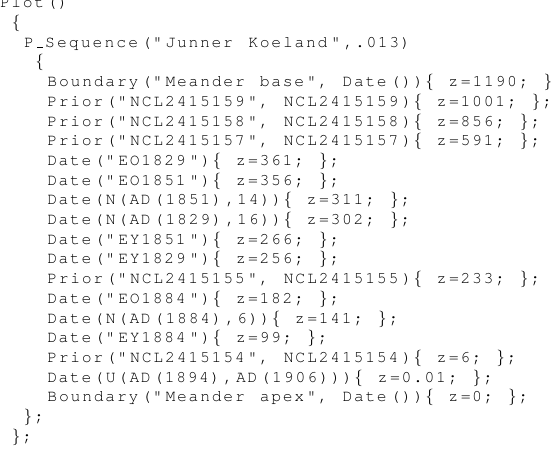
Figure 3. OxCal script as used for the fourth iteration for Junner Koeland. A similar script was used for